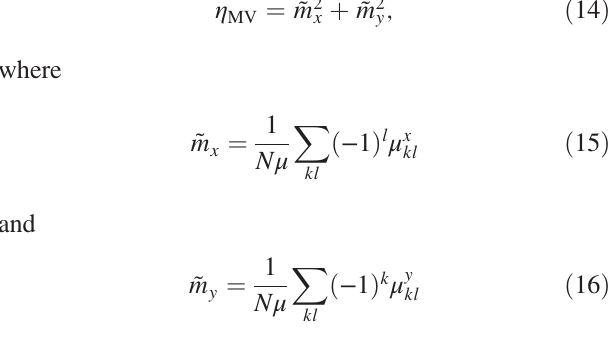
FIG. 8. Time dependence of the MV order parameter η configurational entropy S in the weakly disordered square-lattice ensemble illustrated in Fig. 1(a). The simulations describe the RAQ or the RAS at different temperatures T as